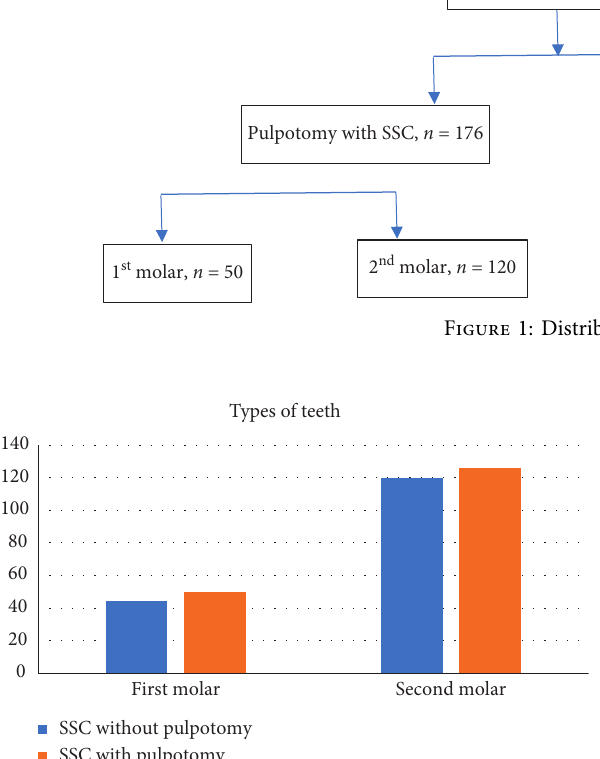
Figure 2: Types of teeth and their distribution among the